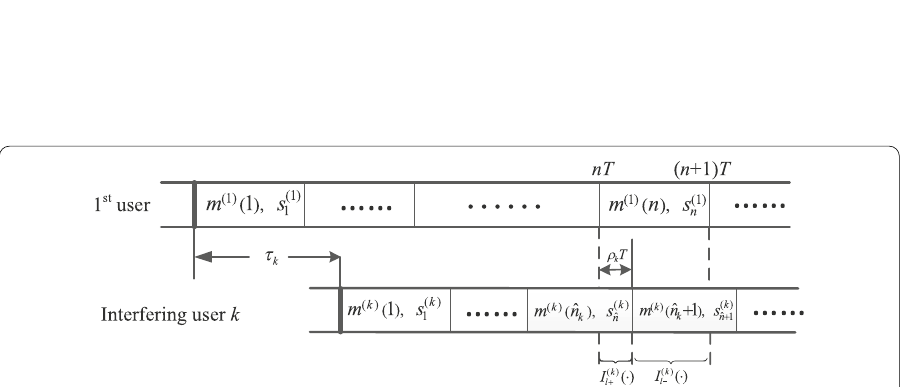
Fig. 3 The illustration of channel slots and MAIs between the 1st user and the interfering user k under time delay τ